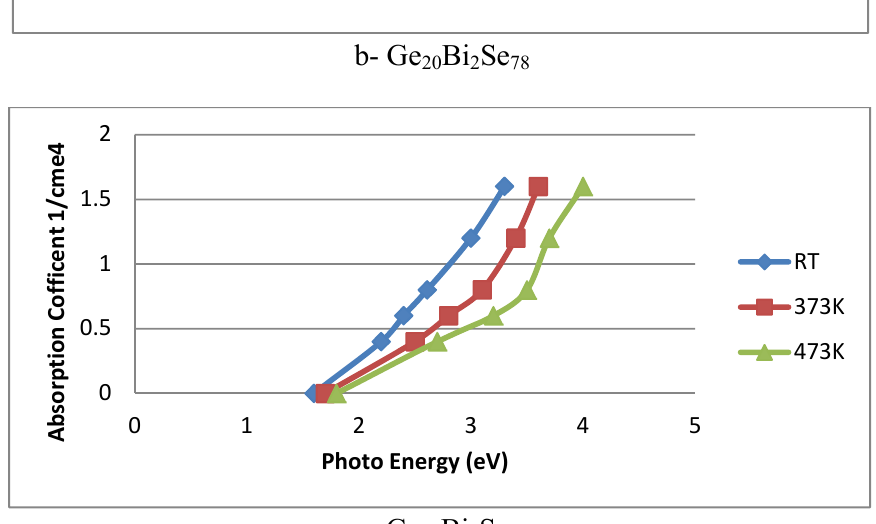
Fig. 4: Absorption coefficient Ge